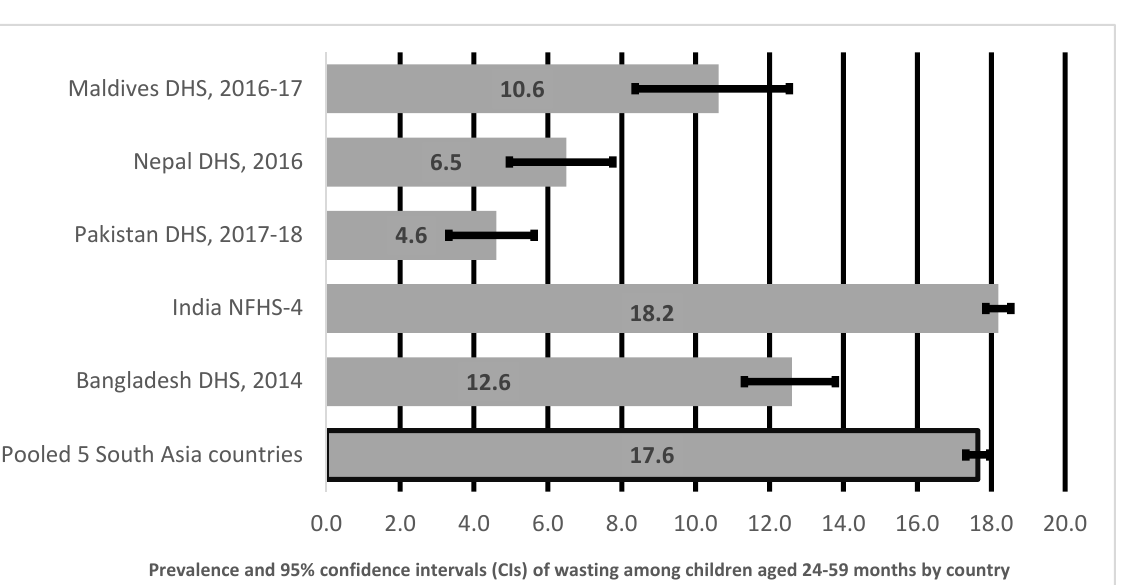
Prevalence and 95% confidence intervals (CIs) of wasting among children aged 24-59 months by country Figure 2. Prevalence and 95% confidence intervals of wasting in children aged 24–59 months in South Asia.